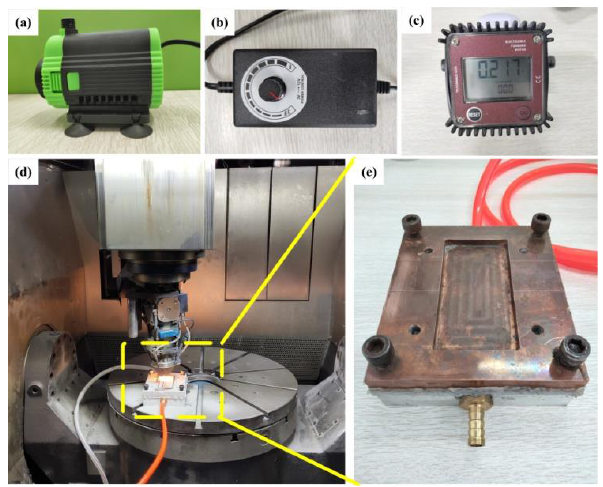
Figure 2. Laser cladding with additional cooling device: ( a ) water pump, ( b ) water flow regulating valve, ( c ) flow meter, ( d ) laser cladding process with additional cooling device, ( e ) cooling device .